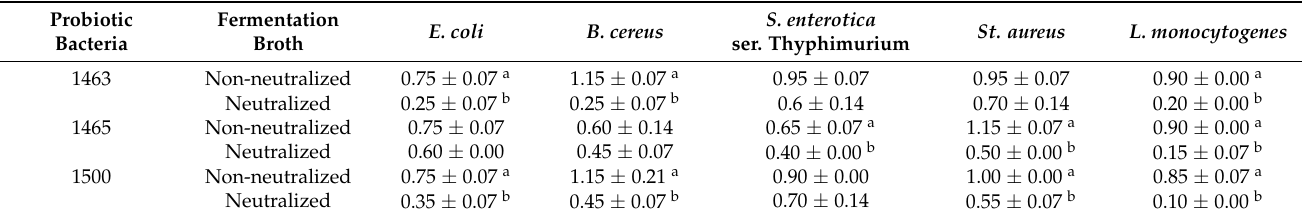
Table 2. Inhibitory effect of inulin-FOSs fermentation broth against foodborne pathogenic bacteria. Probiotic